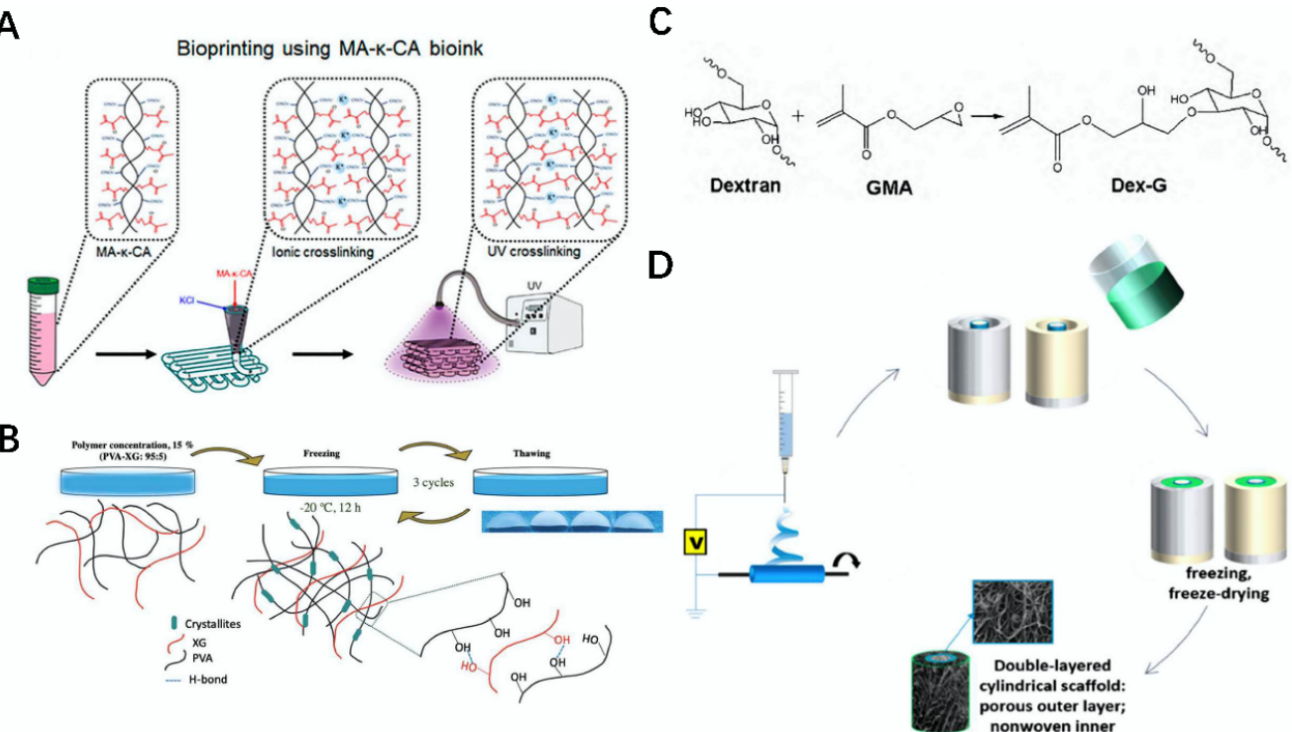
Figure 4. Schematic diagram of the preparation of related polysaccharide bio-inks and bioscaffolds. ( A ) Bioprinting of MA-k-CA bio-ink [70]. ( B ) Schematic diagram of preparation of PVA-XG hydrogel [71]. ( C ) Schematic diagram of preparation of Dex-G glucose-sensitive hydrogel [72]. ( D ) Schematic diagram of preparation of a double-layer tubular biological scaffold modified by heparin [73].